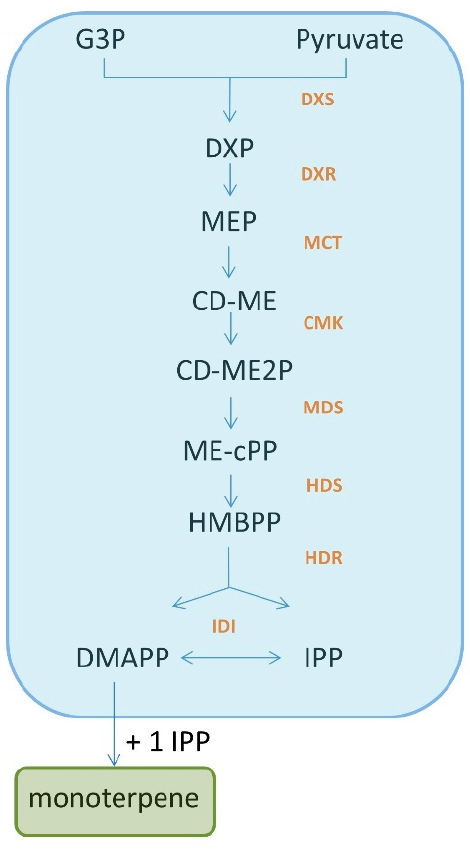
Figure 1. Monoterpene synthesis via IPP and DMAPP pathway based on the MEP pathway of IPP and DMAPP synthesis. The MEP pathway is built-upon pyruvate and glyceraldehyde 3-phosphate (G3P) condensation by thiamine diphosphate enzyme 1-deoxy- ᴅ -xylulose-5-phosphate synthase (DXS) to form 1-deoxy-d-xylulose 5-phosphate (DXP) . The latter is reduced by 1-deoxy- ᴅ -xylulose- 5-phosphate reductoisomerase (DXR) to form MEP. In the next step, MEP is catalysed by 2-C-me- thyl- ᴅ -erythritol 4-phosphate cytidylyltransferase (MCT) to generate 4-(cytidine 5 ′ -diphospho)-2-C- methyl-d-erythritol (CD-ME) . After phosphorylation, cyclisation and ring opening, CD-ME is con- verted into 1-hydroxy-2-methyl- 2-butenyl 4-diphosphate (HMBPP) under the catalysis of 4-diphos- phocytidyl-2-C-methyl-d-erythritol kinase (CMK) , 2-C-methyl-d-erythritol 2,4-cyclodiphosphate syn- thase (MDS) and 4-hydroxy-3-methylbut-2-enyldiphosphate synthase (HDS) , respectively. The IPP and